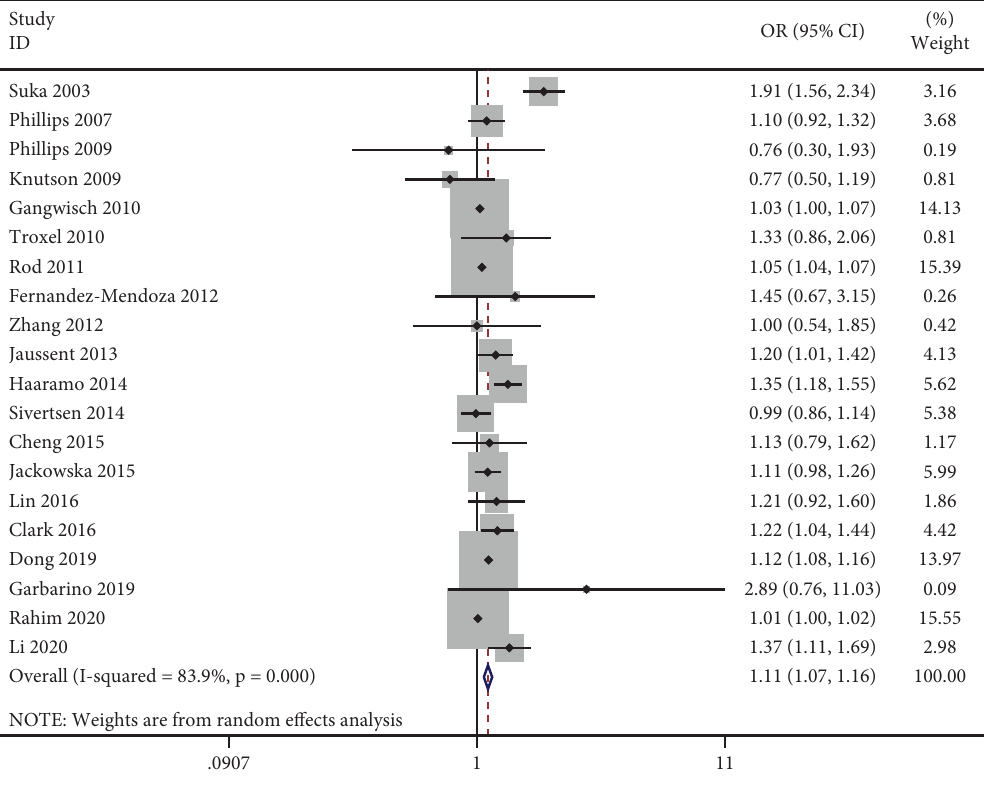
Figure 2: Forest plots of insomnia predicting incident hypertension. Squares represent the study-specifc relative risk. Diamonds represent the summary relative risks (SRRs). Horizontal lines represent 95% confdence intervals